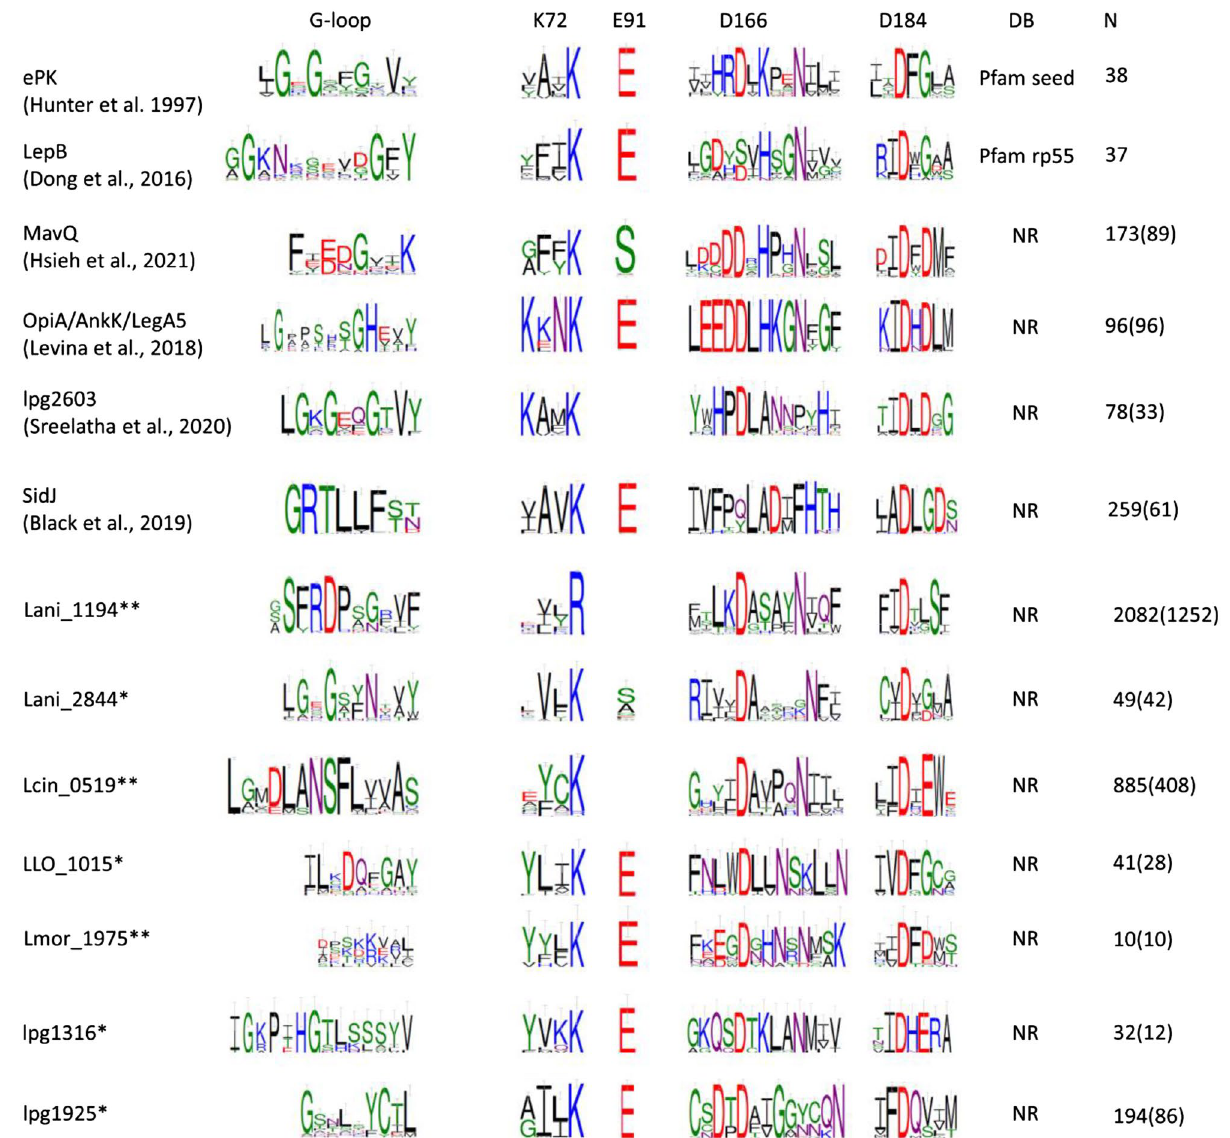
Figure 1. Most Legionella kinase-like families have conserved active site motifs. Sequence logos of active site motifs for selected families. Also, the “classic” kinases (ePK) shown. Residue numbering (top row) according to standard protein kinase A (PKA) nomenclature 26 . Asterisks denote the novel Legionella kinases. Double asterisks denote the novel families discussed in detail. DB: source database of kinase sequences used for the logos 27